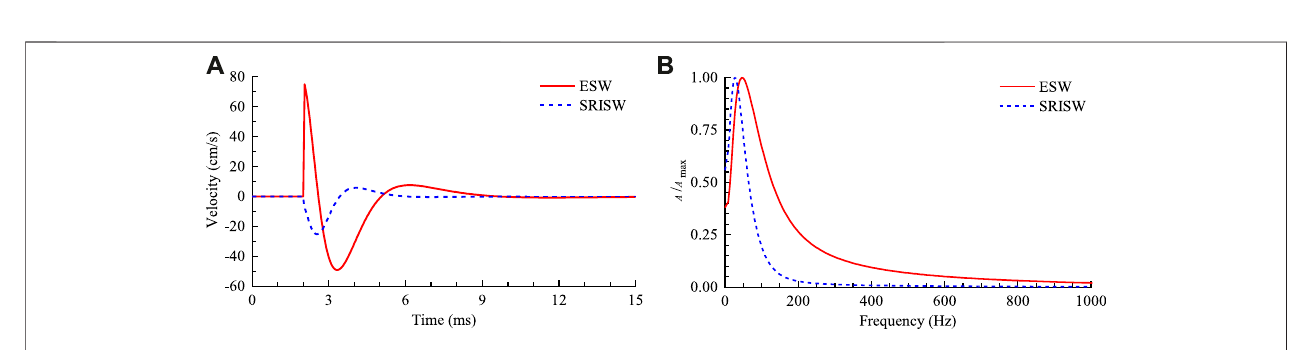
FIGURE 6 | Comparisons of the explosion seismic wave (ESW) and the stress release-induced seismic wave (SRISW). (A) Velocity histories at r = 5 a, (B) Normalized amplitude-frequency spectra of the velocity histories.